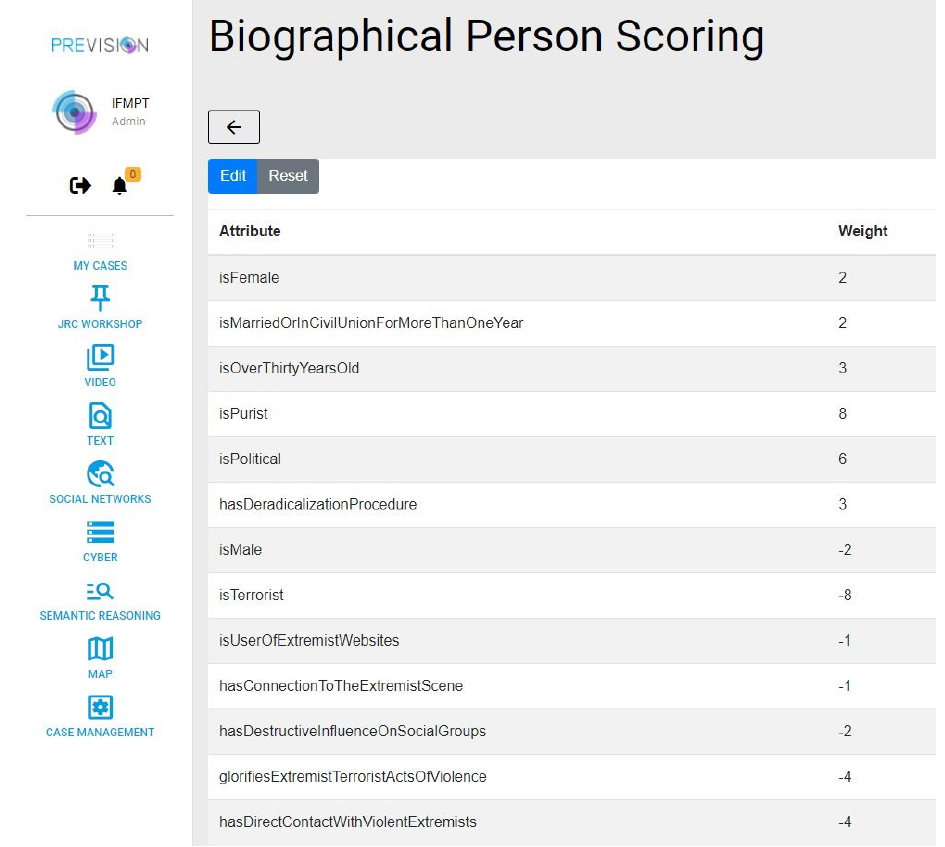
Figure 11. Example of the configuration of the Biographical Person Scoring in PREVISION. Each feature is weighted by LEAs which affects the calculation of the overall radicalisation probability of a